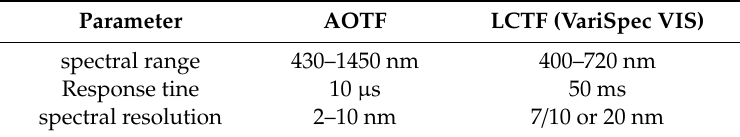
Table 1. The AOTF vs LCTF Major Parameters Specifications.